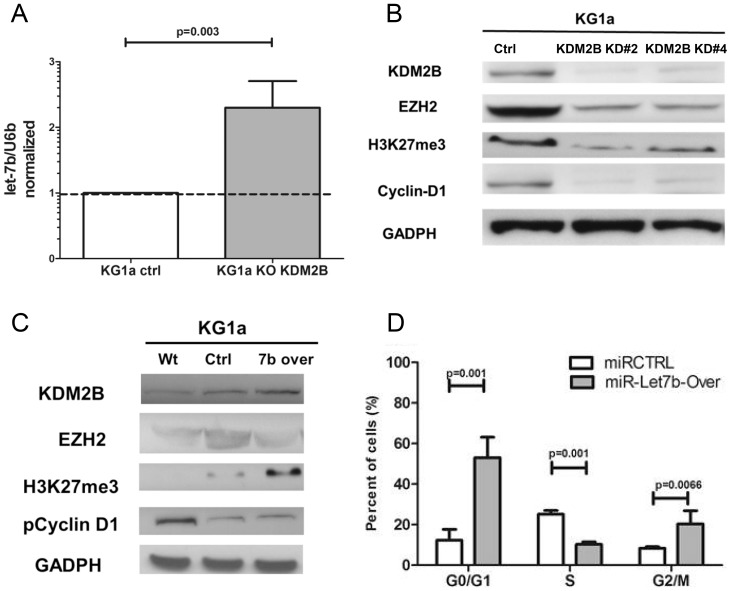
Let-7b overexpression and KDM2B knockdown.
A) Knockdown of KDM2B in KG1a cells was associated with increased expression of let-7b (p = 0.003, Results show the mean±SEM of 3 experiments; Student's t-test, U6B served as loading control) B) Knockdown of KDM2B (constructs #2 and #4) in KG1a cells reduced KDM2B, EZH2, H3K27me3 and Cyclin-D1 protein levels. The blots show one of 3 similar experiments. C) KG1a cells overexpressing let-7b showed increased KDM2B and H3K27m3, and decreased EZH2 protein expression. There was no measurable change of pCyclinD1; GADPH served as control. The blots show one of 3 similar experiments. D) KG1a cells overexpressing let-7b showed decreased BrdU uptake/proliferation (decrease of cells in S phase; p = 0.001, and increase of cells in G1 and G2, p = 0.001 and p = 0.0066, respectively; results show the mean±SEM of 3 experiments; Student's t-test).